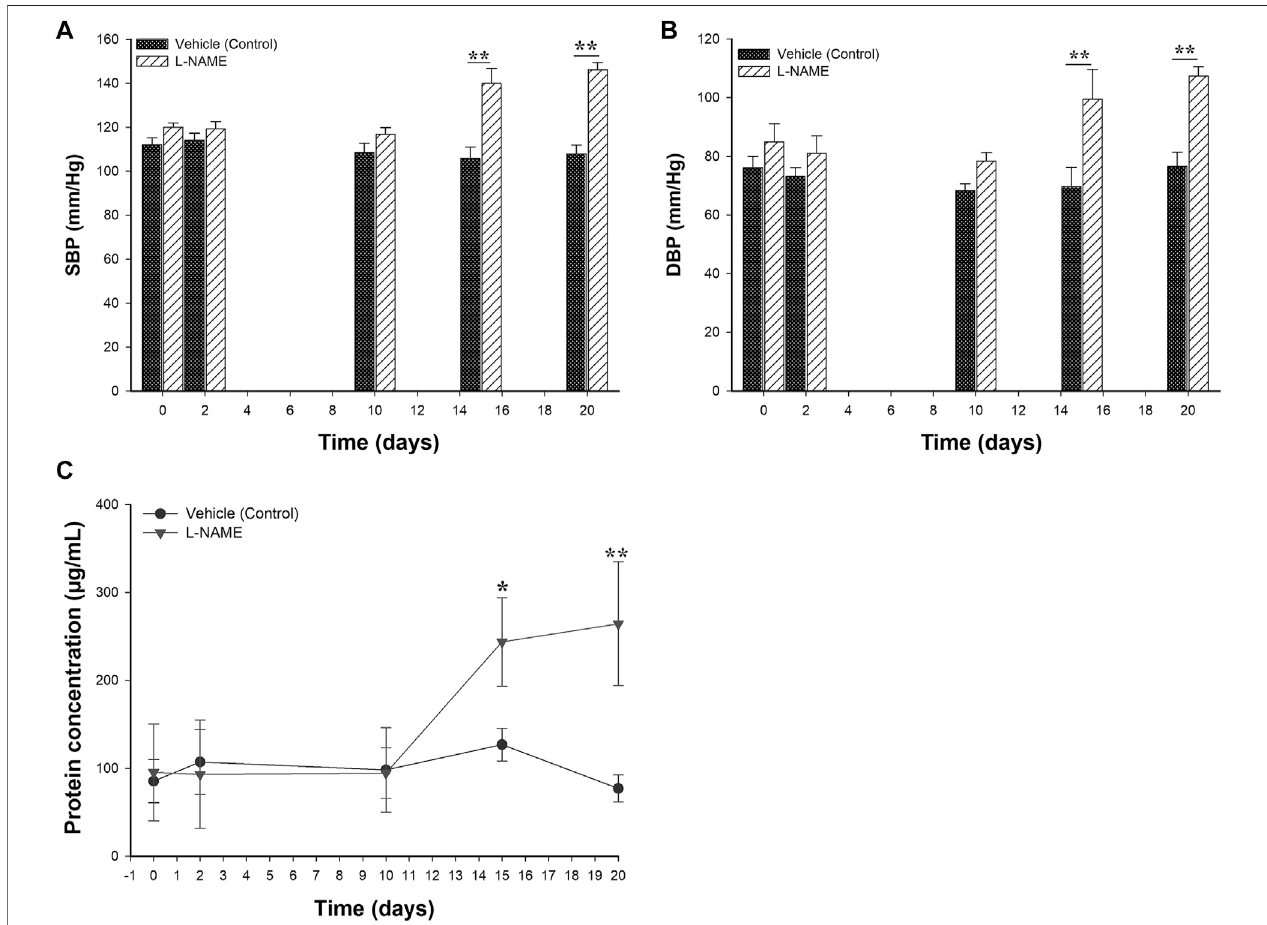
FIGURE2| Effectoftheadministrationof60 mg/kgofL-NAMEonbloodpressurevaluesandproteinurinelevelsinpregnantSpragueDawleyrats.Figure2shows thecomparisonofsystolic (A) anddiastolicbloodpressure (B) valuesandtheurineproteinconcentrations (C) betweentheL-NAMEandvehiclegroups.Bloodpressure measurementsandurineproteinconcentrationswereevaluatedondays0,2,10,15and20ofthegestation.Dataareexpressedasmean ± standarderrorofsevenrats. p -values obtained from the comparison between two groups were obtained using t -test. p -values obtained from comparisons inside the same group throughout the time, were calculated using repeated measures analysis of variance (ANOVA) coupled with the Holm-Sidak method. SBP: systolic blood pressure; DBP: diastolic blood pressure. * p < 0.05, ** p < 0.001.